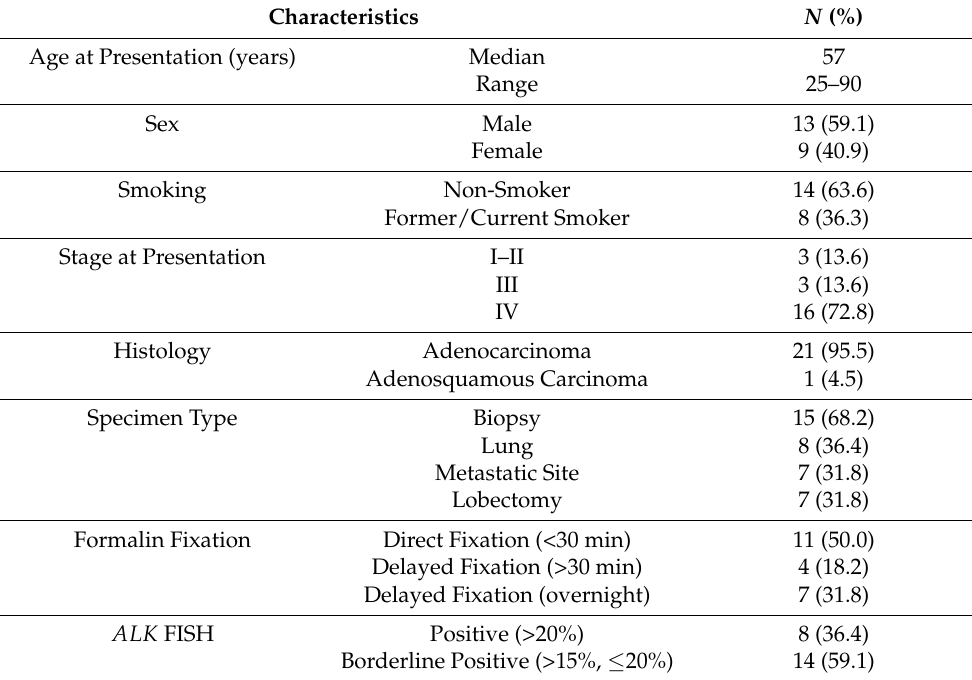
Table 1. Clinical characteristics of 22 discordant cases positive for ALK FISH and negative for ALK IHC.